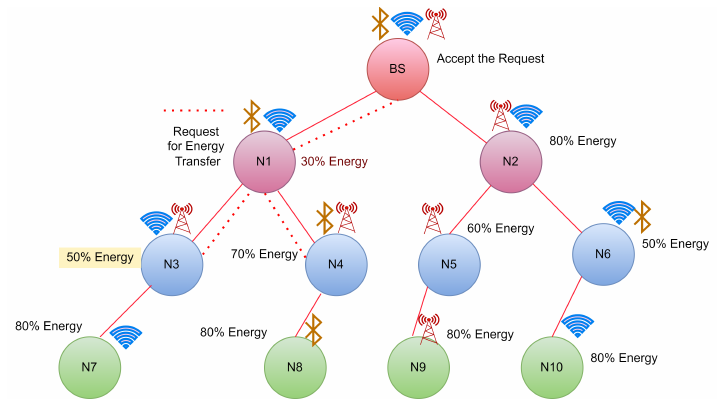
Figure 3. Case 1: Energy request from N1 to its neighbour hops. CASE 2: Energy transfer from the neighbour